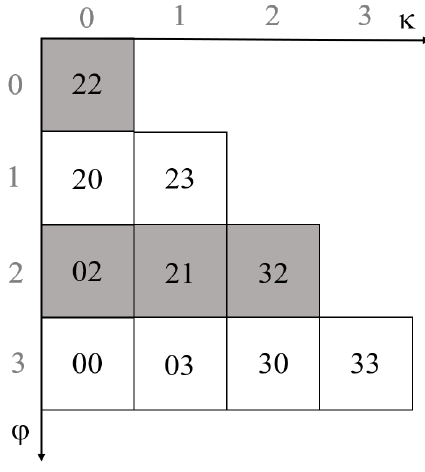
Figure 20. The ϕκ coordinate system of the rhombic grid.